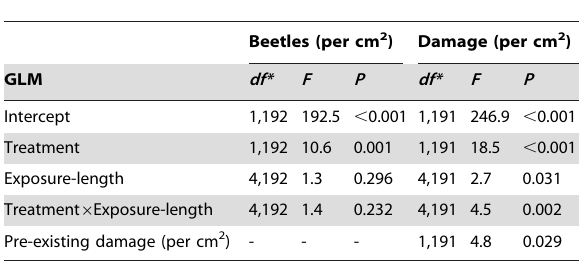
Table 3. The effect of ant treatment exposure-length on beetle choice and herbivory (best-fit models Exp. 6) {